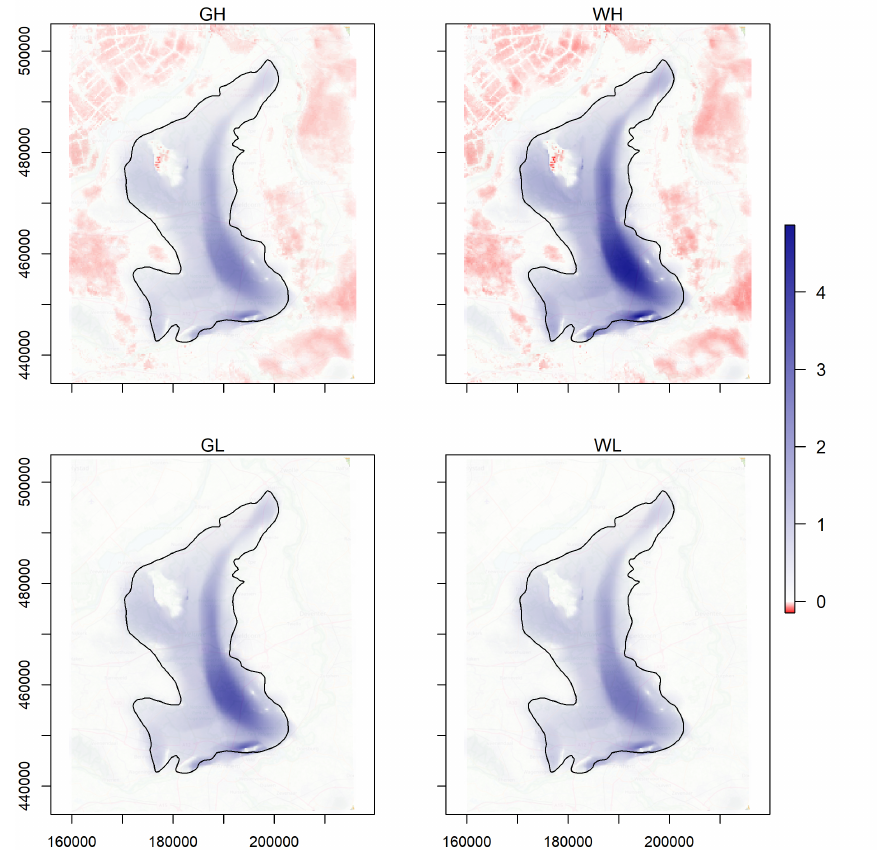
Figure 10. Changes in mean groundwater levels (m) between the climate change scenarios (2036–2065) and the reference period (1981–2010). The boundary of the Veluwe area is indicated in